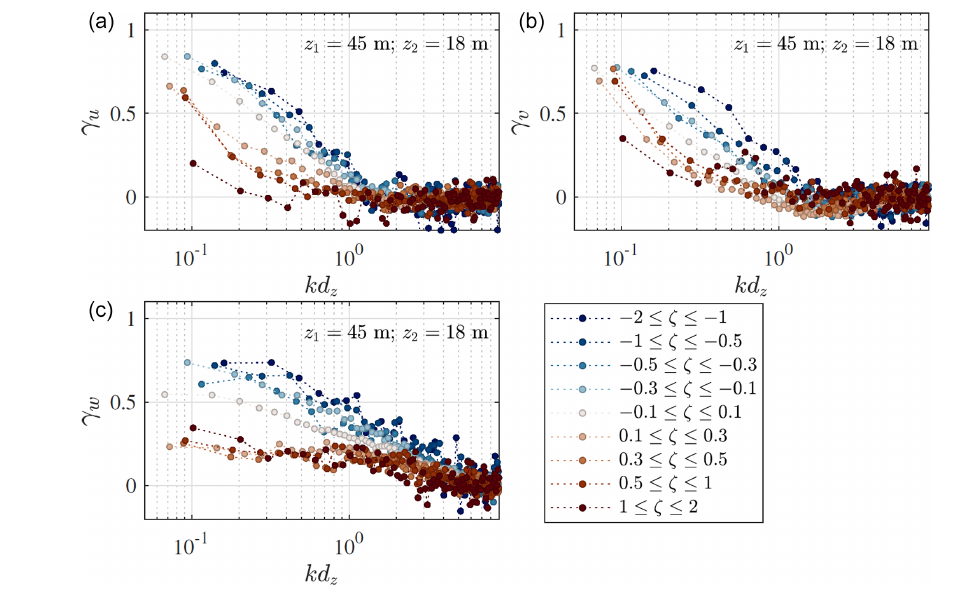
Figure 12. Co-coherence of the along-wind (a) , cross-wind (b) , and vertical (c) velocity components for nine stability classes, given by ζ = z/L . The separation distance is 27m between the sensors at 18m and 45ma.m.s.l.